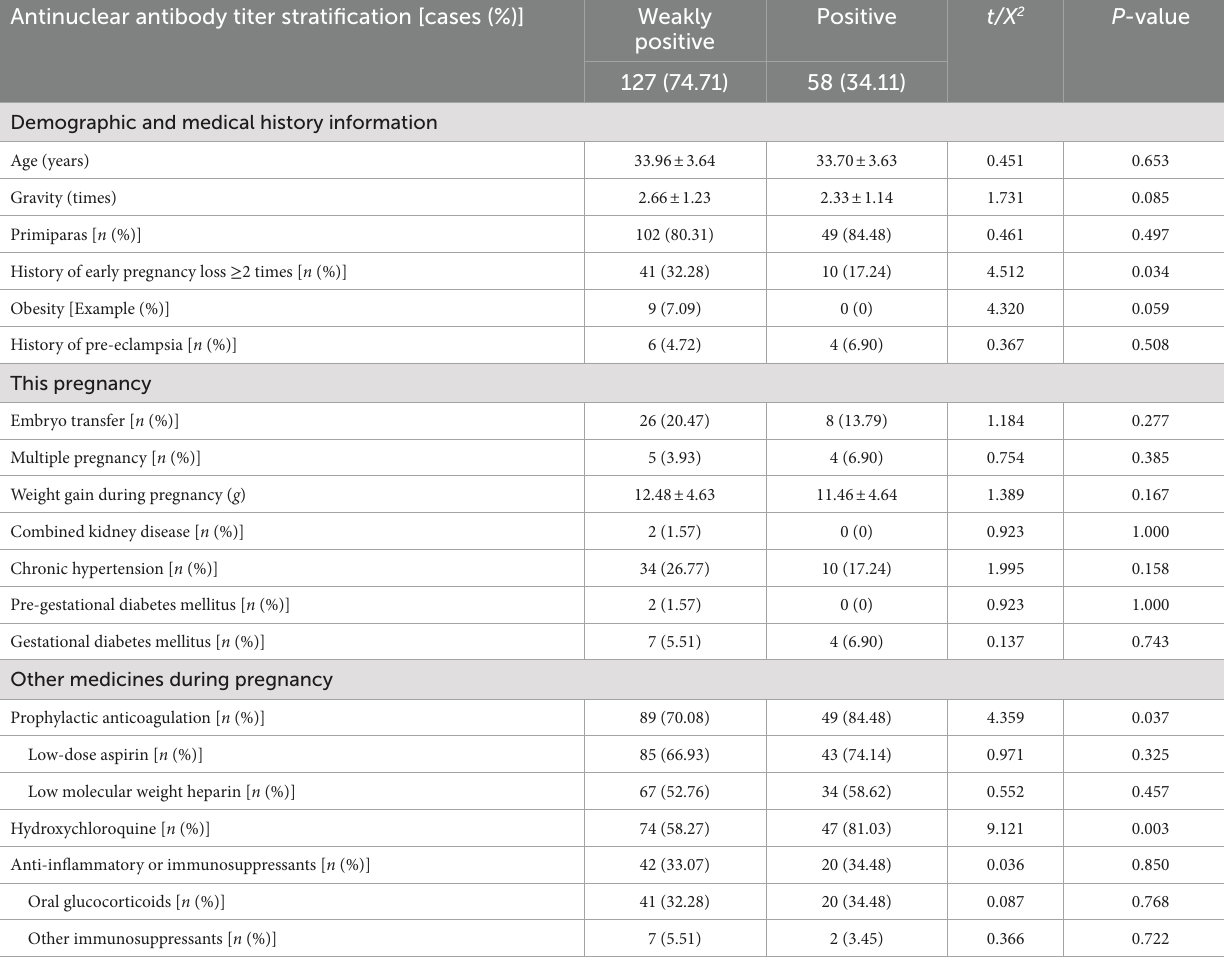
TABLE 3 Demographic information and clinical characteristics of populations with different titers of antinuclear antibodies. Antinuclear antibody titer stratification [cases